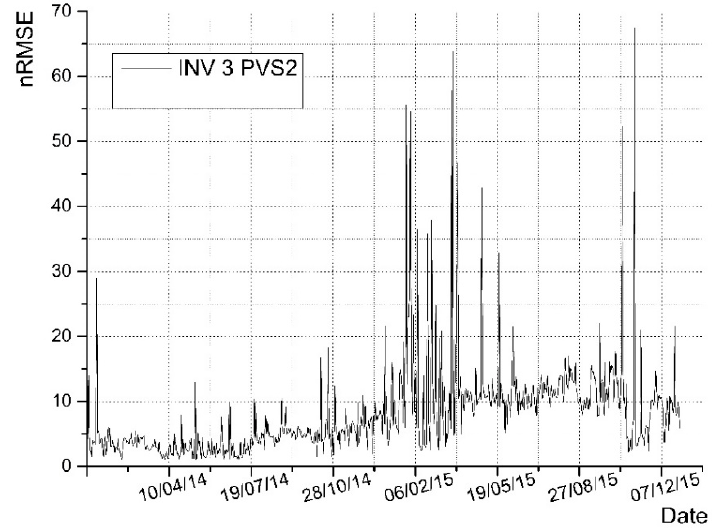
Figure 6. Evolution of NRMSE error during years 2014–2015.